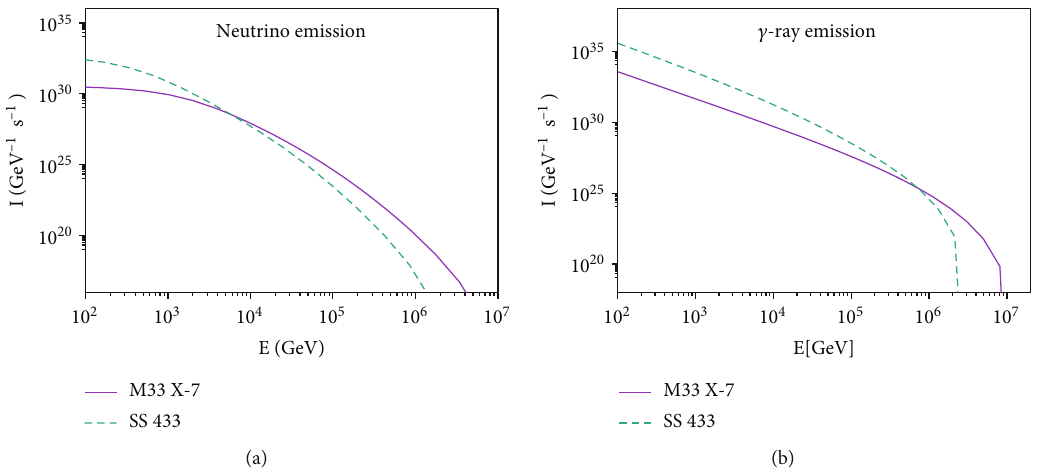
Þ and with that which neglects energy losses N j 0 . 0